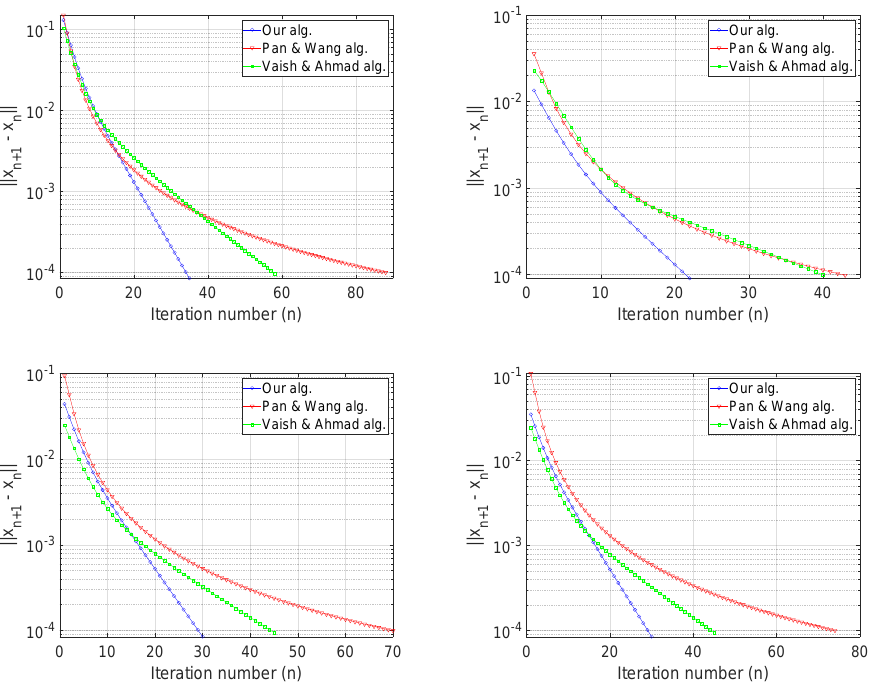
Figure 2. Example 2. Top left: Case I; top right: Case II; bottom left: Case III; bottom right: Case